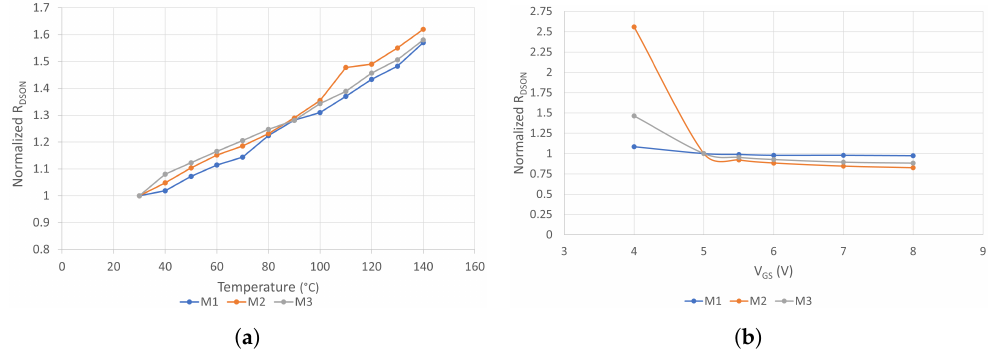
Figure 7. Static measurements for M1, M2, and M3 samples. ( a ) Normalized R DS , ON vs. temperature at V GS = 5 V; ( b ) normalized R DS , ON vs. V GS for ON state.